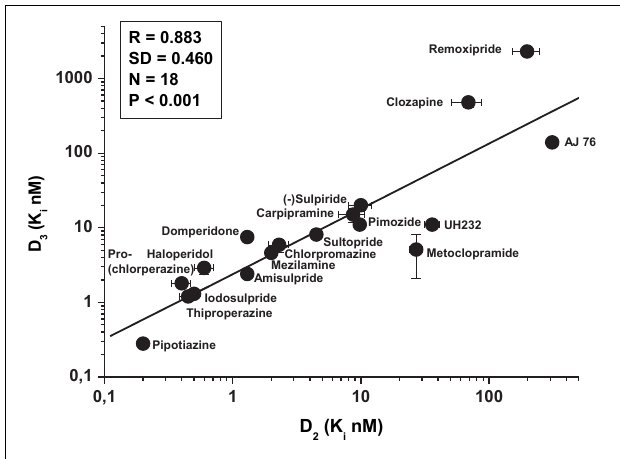
FIGURE 2 | Correlation between in vitro affinity of various dopaminergic antagonists for human recombinant D 3 Rs and D 2 Rs [data taken from Sokoloff et al. (80)]; ligand: [ 125